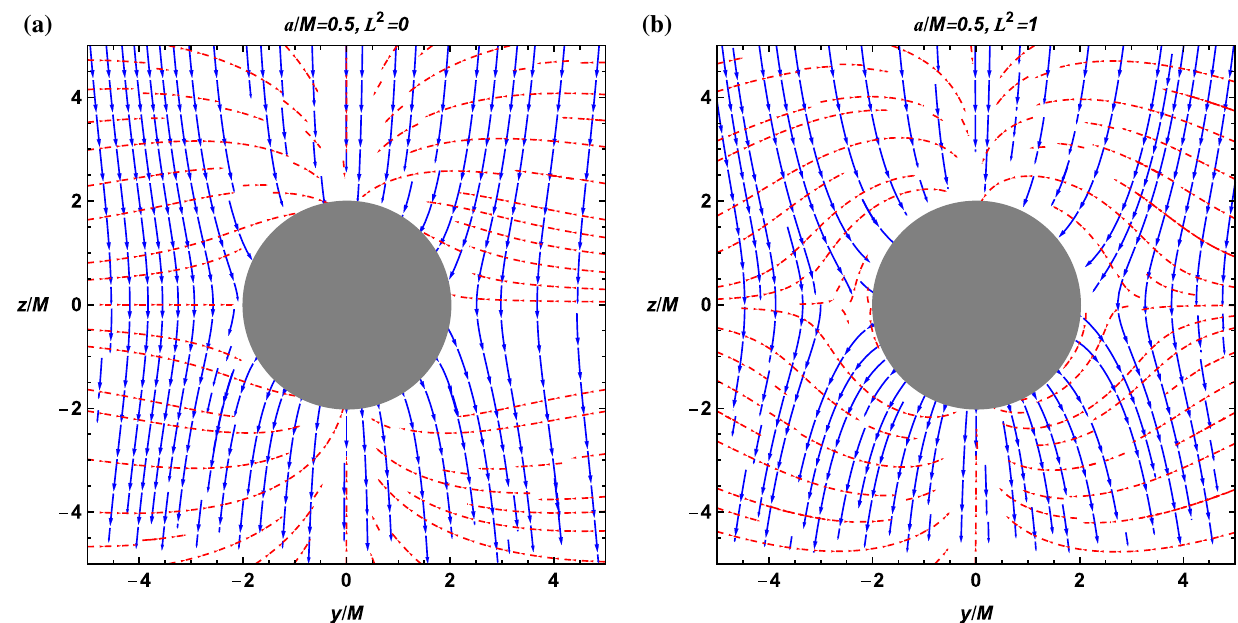
Fig. 2 Structure of the magnetic and electric fields around a black hole. Blue and red lines correspond to magnetic and electric fields,